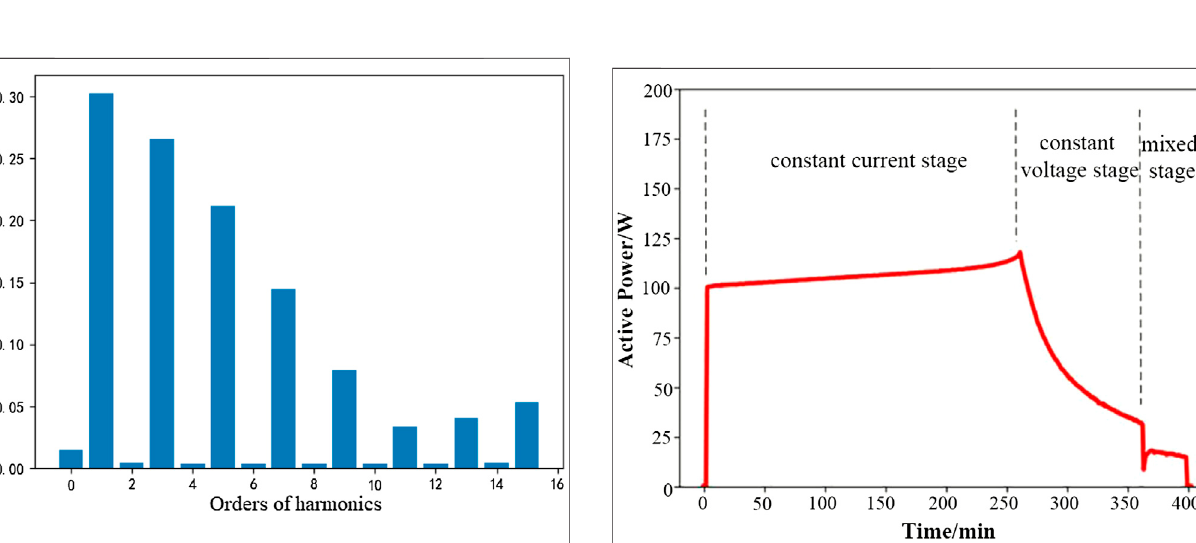
FIGURE 2 | Current waveform during the electric bicycle charging.